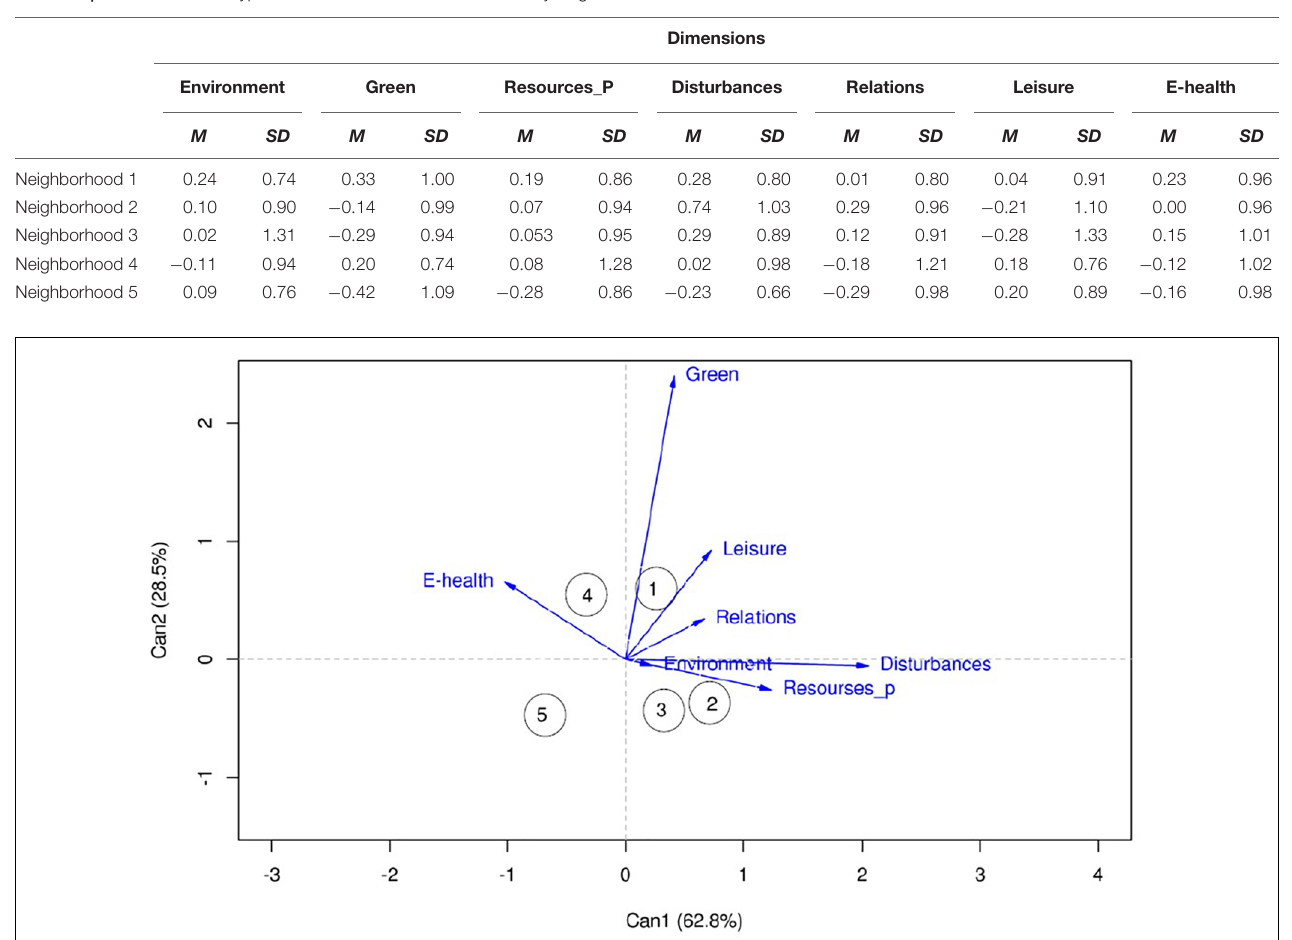
FIGURE 2 | Canonical functions of the MANOVA for Perception Factors ∗ Neighborhood